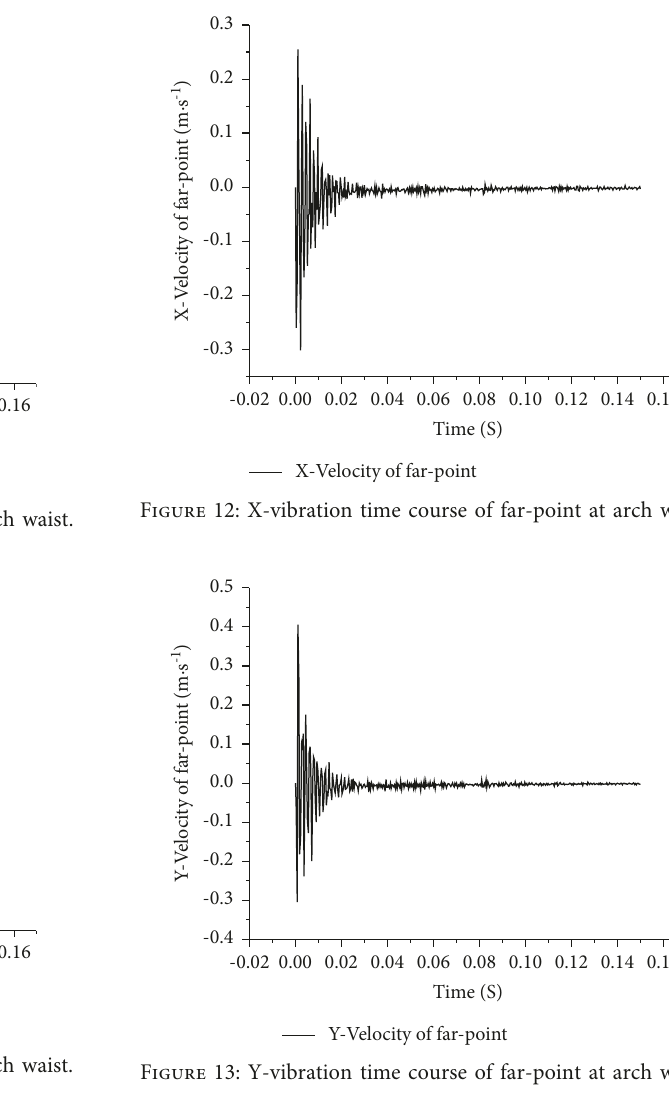
Figure 9: Distribution of peak vibration velocity of lining section. (a)-(o). (a) Peak particle velocity in X direction of 1# section. (b) Peak particle velocity in Y direction of 1# section. (c) Peak particle velocity in the Z direction of 1# section. (d) Peak particle velocity in the X direction of 2# section. (e) Peak particle velocity in the Y direction of 2# section. (f) Peak particle velocity in the Z direction of 2# section. (g) Peak particle velocity in the X direction of 3# section. (h) Peak particle velocity in the Y direction of 3# section. (i) Peak particle velocity in the Z direction of 3# section. (j) Peak particle velocity in the X direction of 4# section. (k) Peak particle velocity in the Y direction of 4# section. (l) Peak particle velocity in the Z direction of 4# section. (m) Peak particle velocity in the X direction of 5# section. (n) Peak particle velocity in the Y direction of 5# section. (o) Peak particle velocity in the Z direction of 5# section.